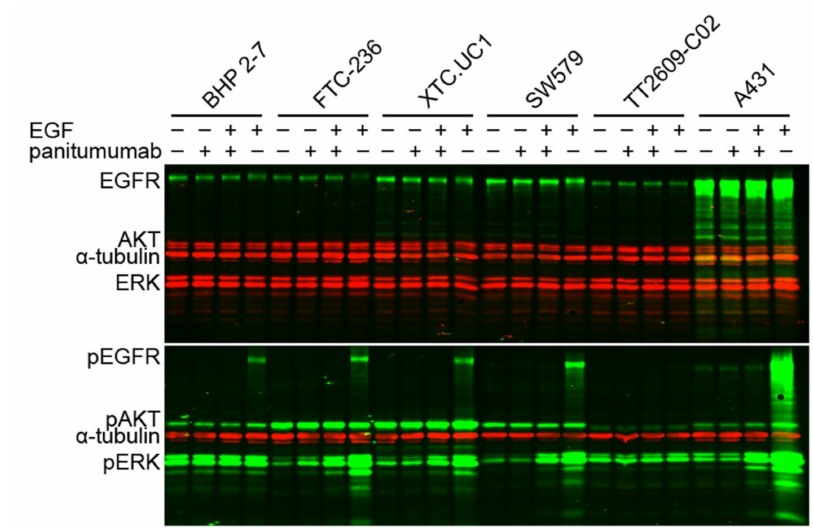
Figure 5. Immunofluorescent Western blots. Thyroid cancer cell lines (BHP 2–7, FTC-236, XTC.UC1, SW579, TT2609-C02) and the EGFR overexpressing control A431, were either serum-starved ( − ) or treated ( + ) with panitumumab for 1 h (20 µ g / mL) and stimulated with ( + ) EGF from mouse for 10 minutes (100 ng / mL) or EGF unstimulated ( − ). A housekeeping protein, anti- α -tubulin antibody was used as loading control. The presence of EGFR, AKT, and ERK proteins in all cells, was confirmed by Western blotting. The same lysates were analyzed by Western blotting with phospho-EGFR (pEGFR), phospho-AKT (pAKT), and phospho-ERK (pERK) antibody. EGF induced EGFR phosphorylation (lane four of each cell line, compared to lane one) in all cell lines, except for TT2609-C02 ( NRAS mutation). Panitumumab alone did not alter the EGFR phosphorylation status (lane 2, control). EGF-induced pEGFR phosphorylation was inhibited by panitumumab (third lane compared to the fourth). pERK showed a partial e ff ect to panitumumab, in BHP 2–7, and TT2609-C02 pERK seems constitutively activated. pAKT seems constitutively activated in all cells (at low levels in TT2609-C02), and at significantly higher levels in the NHG harboring FTC-236 and XTC.UC1 cells in particular. Four gels were used in the same run ( BHP 2-7, FTC-236, XTC.UC1 loaded onto one gel for the protein, comprising the 12 vertical lanes on the upper left, and another one for phosphoprotein markers respectively, depicted on the left below. SW579, TT2609-C02, and A431 were depicted onto the other two gels on the right). All gels were prepared simultaneously from the same mixture and all experimental procedures were run and processed simultaneously (also see Supplemental Figures